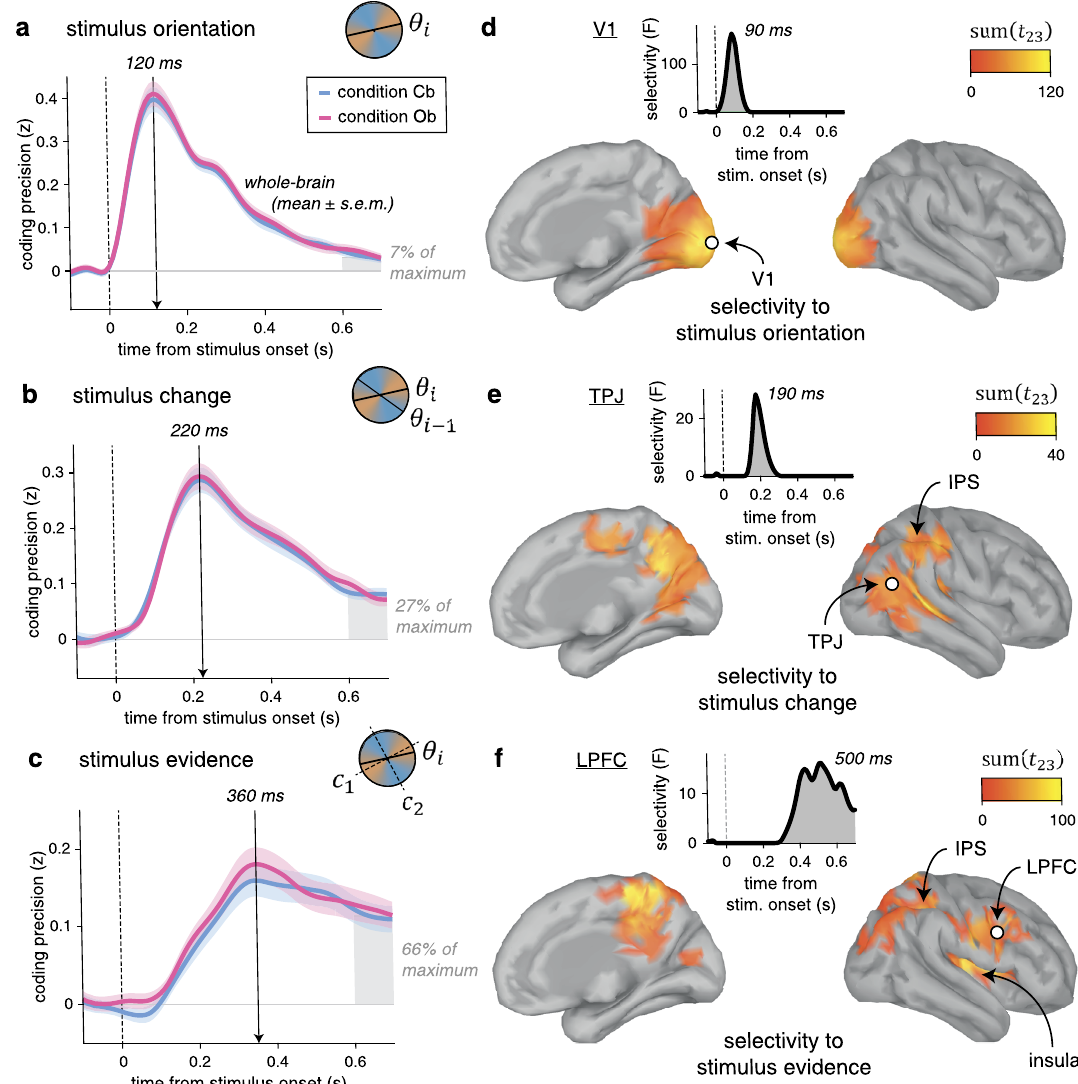
Fig. 4 Neural correlates of stimulus processing. a Time course of neural coding of stimulus orientation from whole-brain MEG signals. Stimulus orientation coding peaks at 120 ms following stimulus onset, with equal precision across conditions. Lines and shaded error bars indicate means ± SEM. b Time course of neural coding of stimulus change. Stimulus change coding peaks at 220 ms following stimulus onset, with equal precision across conditions. c Time course of neural coding of stimulus evidence. Stimulus evidence peaks at 360 ms following stimulus onset, with equal precision across conditions. The shaded area at 600 – 700 ms is used as reference for the three stimulus characteristics to compute their relative coding precision expressed as fraction of their respective maximum value. d Searchlight-based coding of stimulus orientation across the cortical surface (left: medial view, right: lateral view). The bilateral spatiotemporal cluster found in early visual cortex (including V1), marginalized across time (cluster de fi nition p = 0.001, cluster statistic p < 0.001) corresponds to cortical sources for which the coding precision of stimulus orientation signi fi cantly exceeds the coding precision of stimulus change and stimulus evidence. Inset: time course of the selectivity statistic for a cortical source in V1 (white dot). e Searchlight-based coding of stimulus change. Change-selective clusters are found in the TPJ and the PPC. Inset: time course of the selectivity statistic for a cortical source in the TPJ (white dot). f Searchlight-based coding of stimulus evidence. Evidence-selective clusters are found in the PPC, the LPFC, and the insula. Inset: time